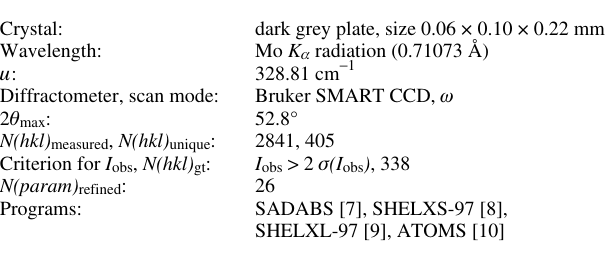
Table 1. Data collection and